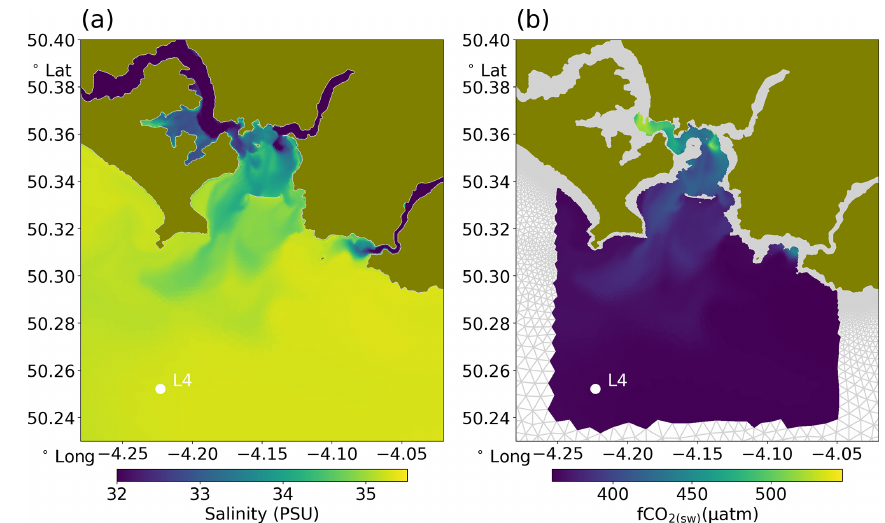
Figure 10. (a) Model surface salinity field on 7 July at the midpoint of the observational transect. Note that the range of the colour bar was restricted to better depict salinity in the lower estuary, and thus salinity in the upper estuaries is beyond the range of the colour bar. (b) Derived ξ f CO 2 using the determined ξS and ξ f CO 2